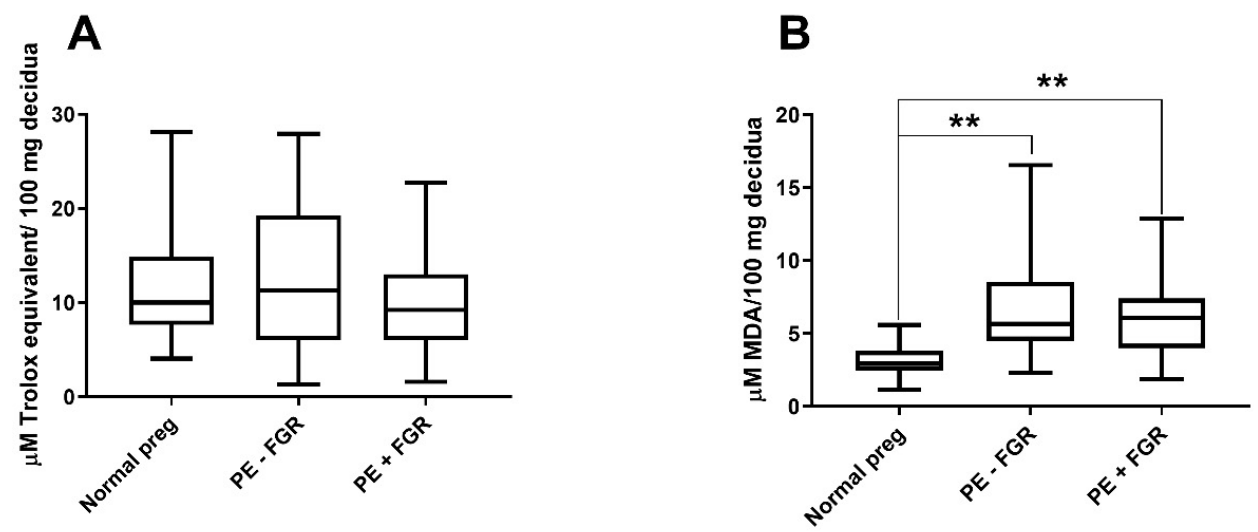
Figure 1. Non-enzymatic antioxidant capacity and oxidative-stress levels in decidua. Decidual non-enzymatic antioxidant capacity expressed as µ M Trolox equivalent levels per 100 mg decidual tissue ( A ). Decidual oxidative-stress levels assessed by malondialdehyde (MDA) concentrations per 100 mg decidual tissue ( B ). Comparisons between normal pregnancies (preg) and preeclampsia (PE) with or without fetal growth restriction (FGR) ( A , B ). Boxes with medians extend from the 25th to 75th percentiles. ** p < 0.001. Table 2. Gene-set enrichment analysis of NRF2-regulated functional gene sets. Comparison between Diagnostic Groups Gene-Set Description No. of